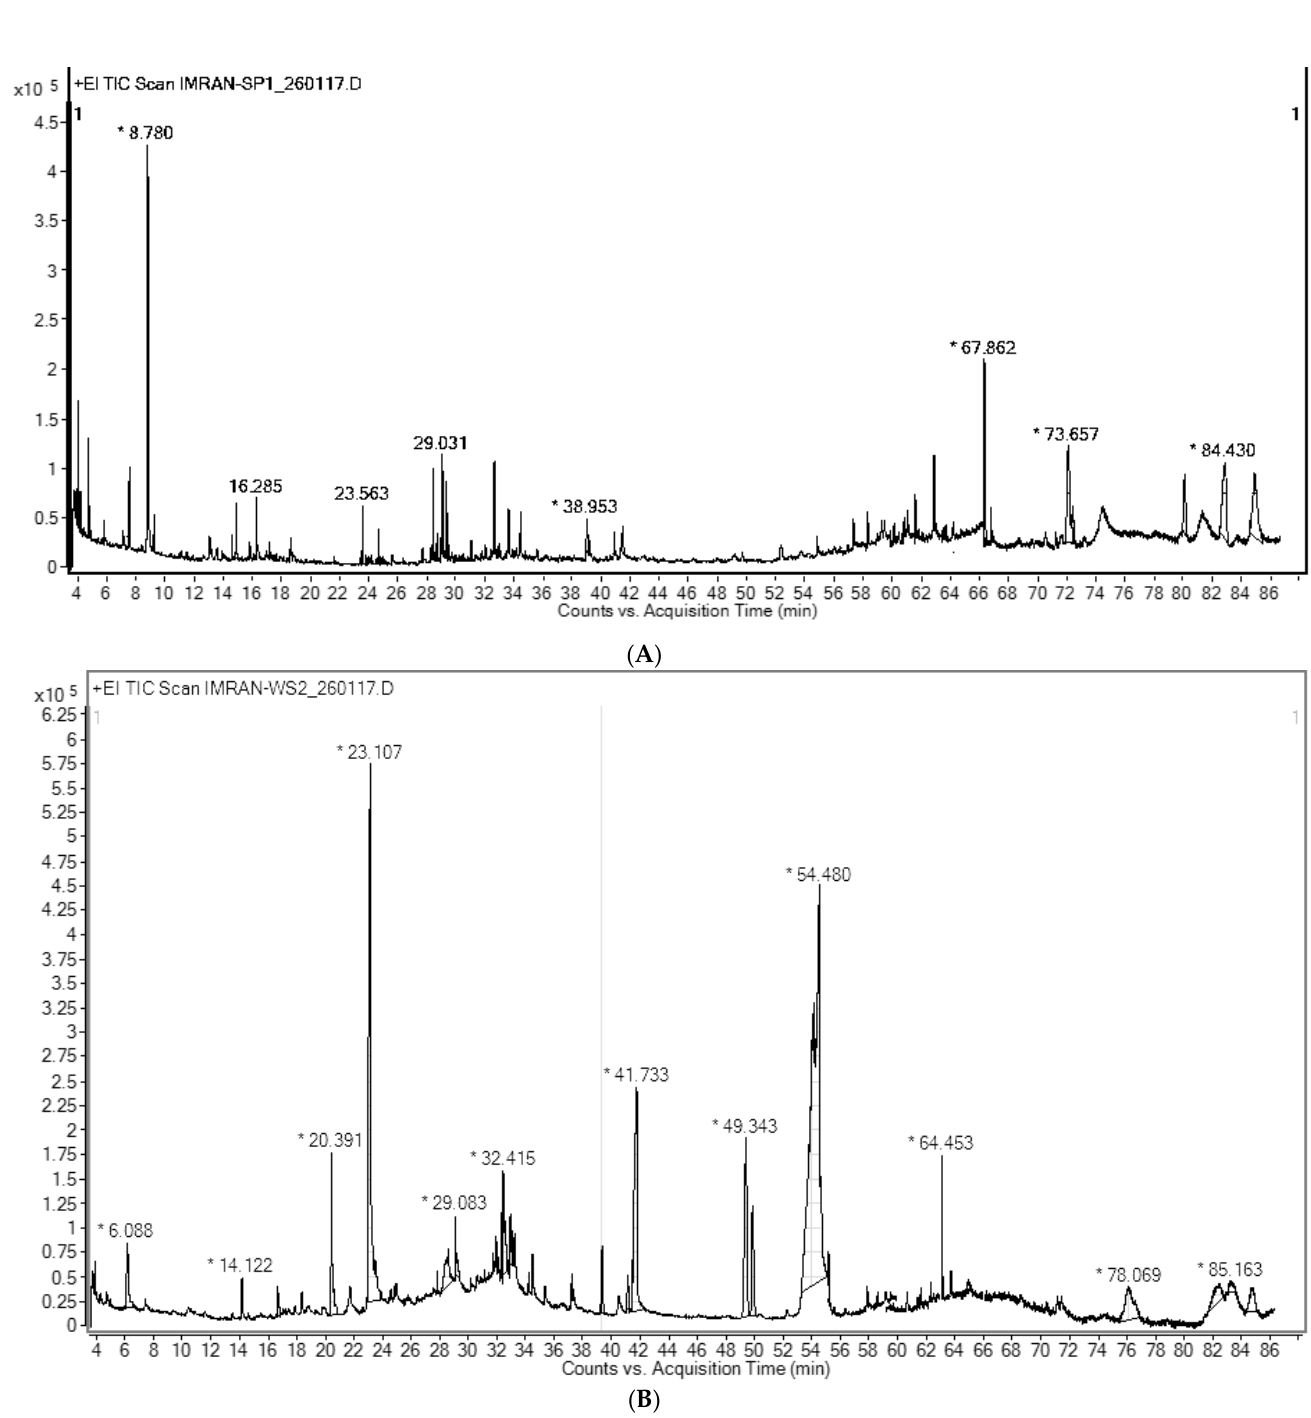
Figure 1. ( A ) Total Ion Chromatogram (TIC) of EOAS; ( B ) Total Ion Chromatogram (TIC) of EOAA. * = identification matched > 50 % with database